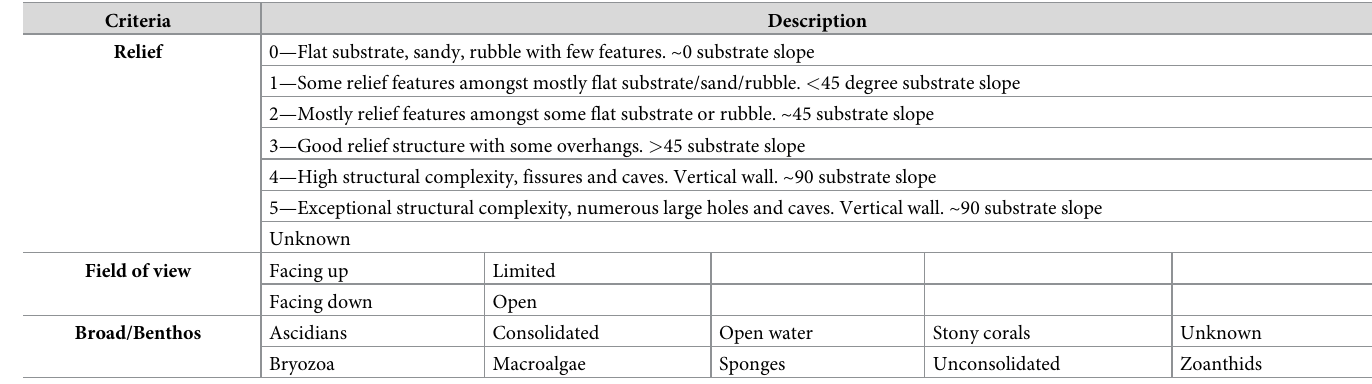
Table 1. Habitat classification based on broad CATAMI Classification scheme [68] and on Wilson et al. [69], used in Baited Remote Underwater stereo-Videos and Diver Operated stereo-Videos images.